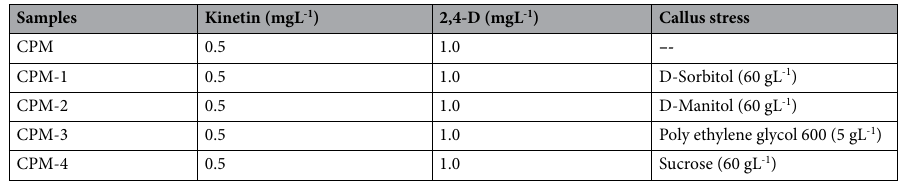
Table 1. Different stress for phytochemical comparison of callus grown on simple callus promoting media (CPM) supplemented with Kinetin (0.5 mgL -1 ) and 2.4-D (1.0 mgL -1 ) and callus subjected to various stresses i.e. 60 gL -1 D-Sorbitol stress (CPM-1), 60 gL -1 D-Manitol (CPM-2), 5 gL -1 Poly ethylene glycol 600 (CPM-3) and 60 gL -1 Sucrose